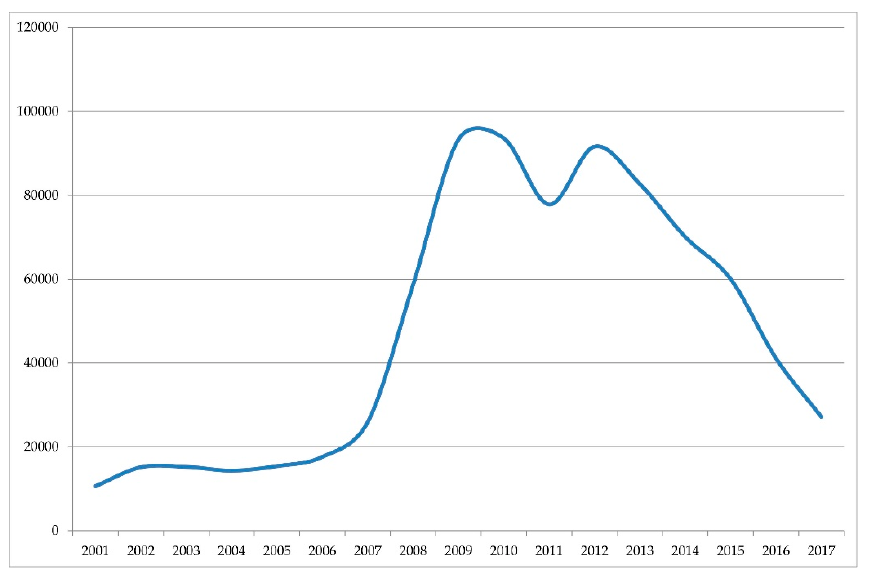
Figure 1. Number of the foreclosures initiated on homes per year in Spain. Data: General Council of the Judiciary. Own production.